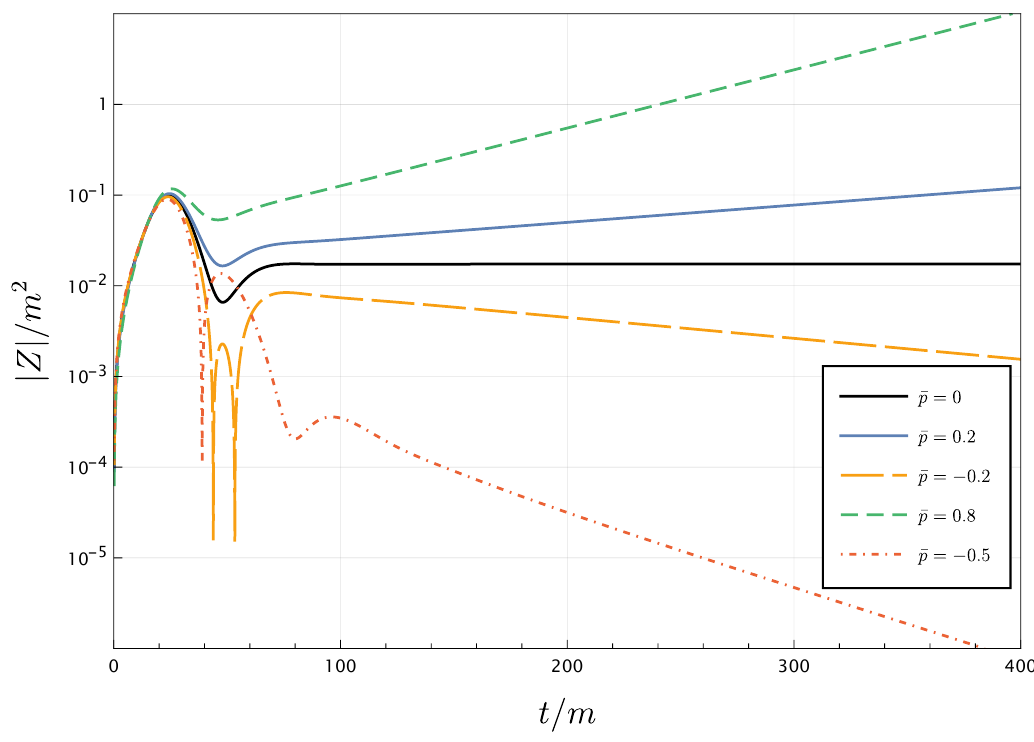
Figure 3 . Evolution of | Z | /m 2 as a function of t/m at fixed radius, for ‘ = 0 and different values of ¯ p . The cosmological constant is set to Λ = 0 . 001 /m 2